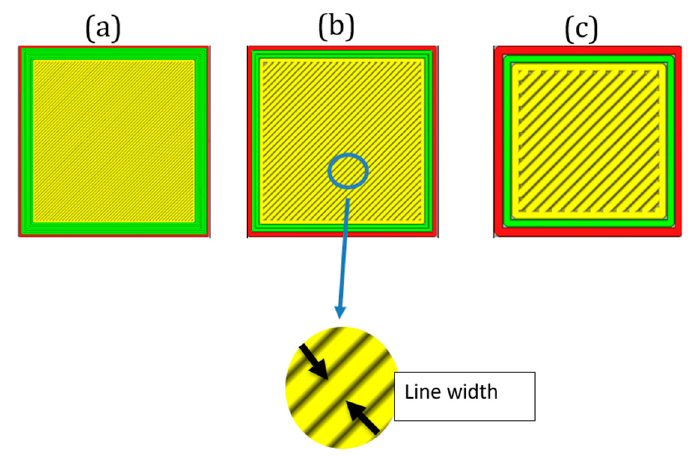
Figure 14. Three di ff erent line widths: ( a ) 0.2 mm, ( b ) 0.4 mm, and ( c ) 0.8 Figure 14. Three different line widths: ( a ) 0.2 mm, ( b ) 0.4 mm, and ( c ) 0.8 mm.